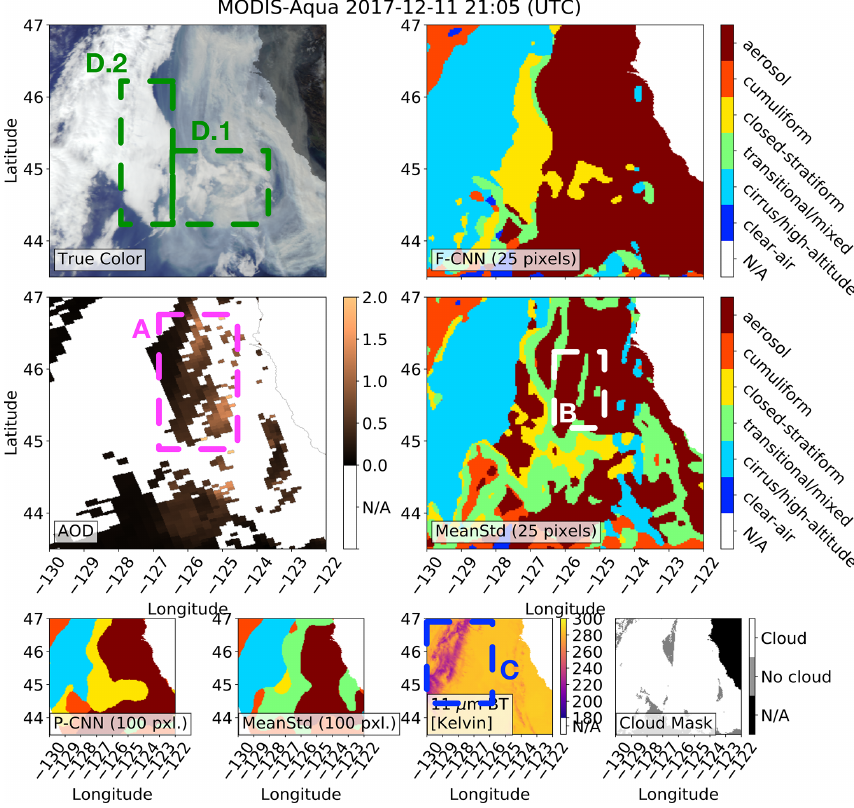
Figure 9. Box A shows where (1) the MODIS MYD04 aerosol product has bad aerosol optical depth (AOD) retrievals which are flagged as bad by the MYD04 quality control, (2) the MODIS MYD35 cloud-mask product labeled the aerosols as clouds, and (3) the pretrained 100- pixel CNN and fine-tuned 25-pixel CNN (F-CNN) methods were able to successfully detect the extreme aerosols. Box B shows where the baseline mean–standard deviation (MeanStd) methods misclassified the aerosols as clouds. Box C shows the presence of dense cirrus/high- altitude clouds with 11µm brightness temperatures (BTs) ranging between 242 and 253K and where all four methods were able to detect the cirrus/high-altitude cloud. Box D shows possible closed-stratiform clouds which are near or under the smoke plume. All four methods were able to detect the closed-stratiform clouds to various degrees, whereas the 25-pixel methods were able to detect the closed-stratiform clouds at − 127 longitude at a finer image resolution compared to the 100-pixel methods. For all images any sun glint and landmasses have been masked